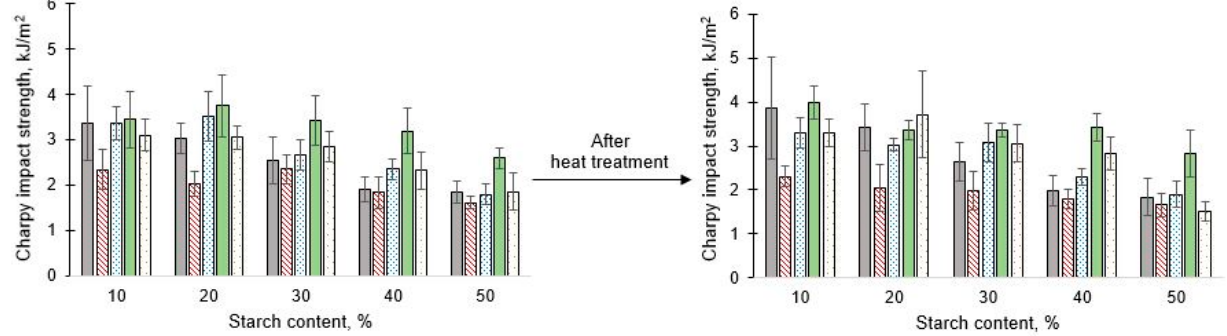
Figure 7. Charpy impact strength of unconditioned and conditioned PLA/starch blends.